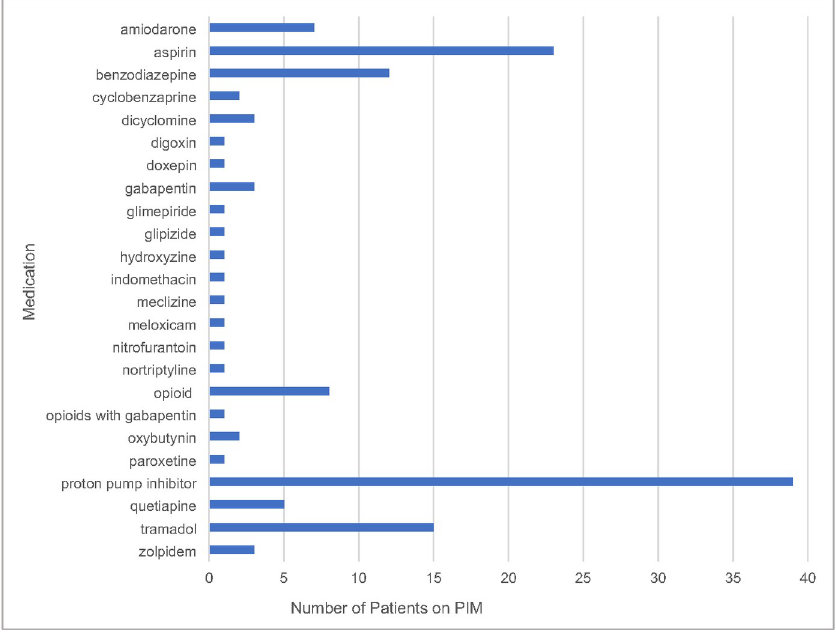
Fig 1. Frequency of potentially inappropriate medications in home care patients (N =